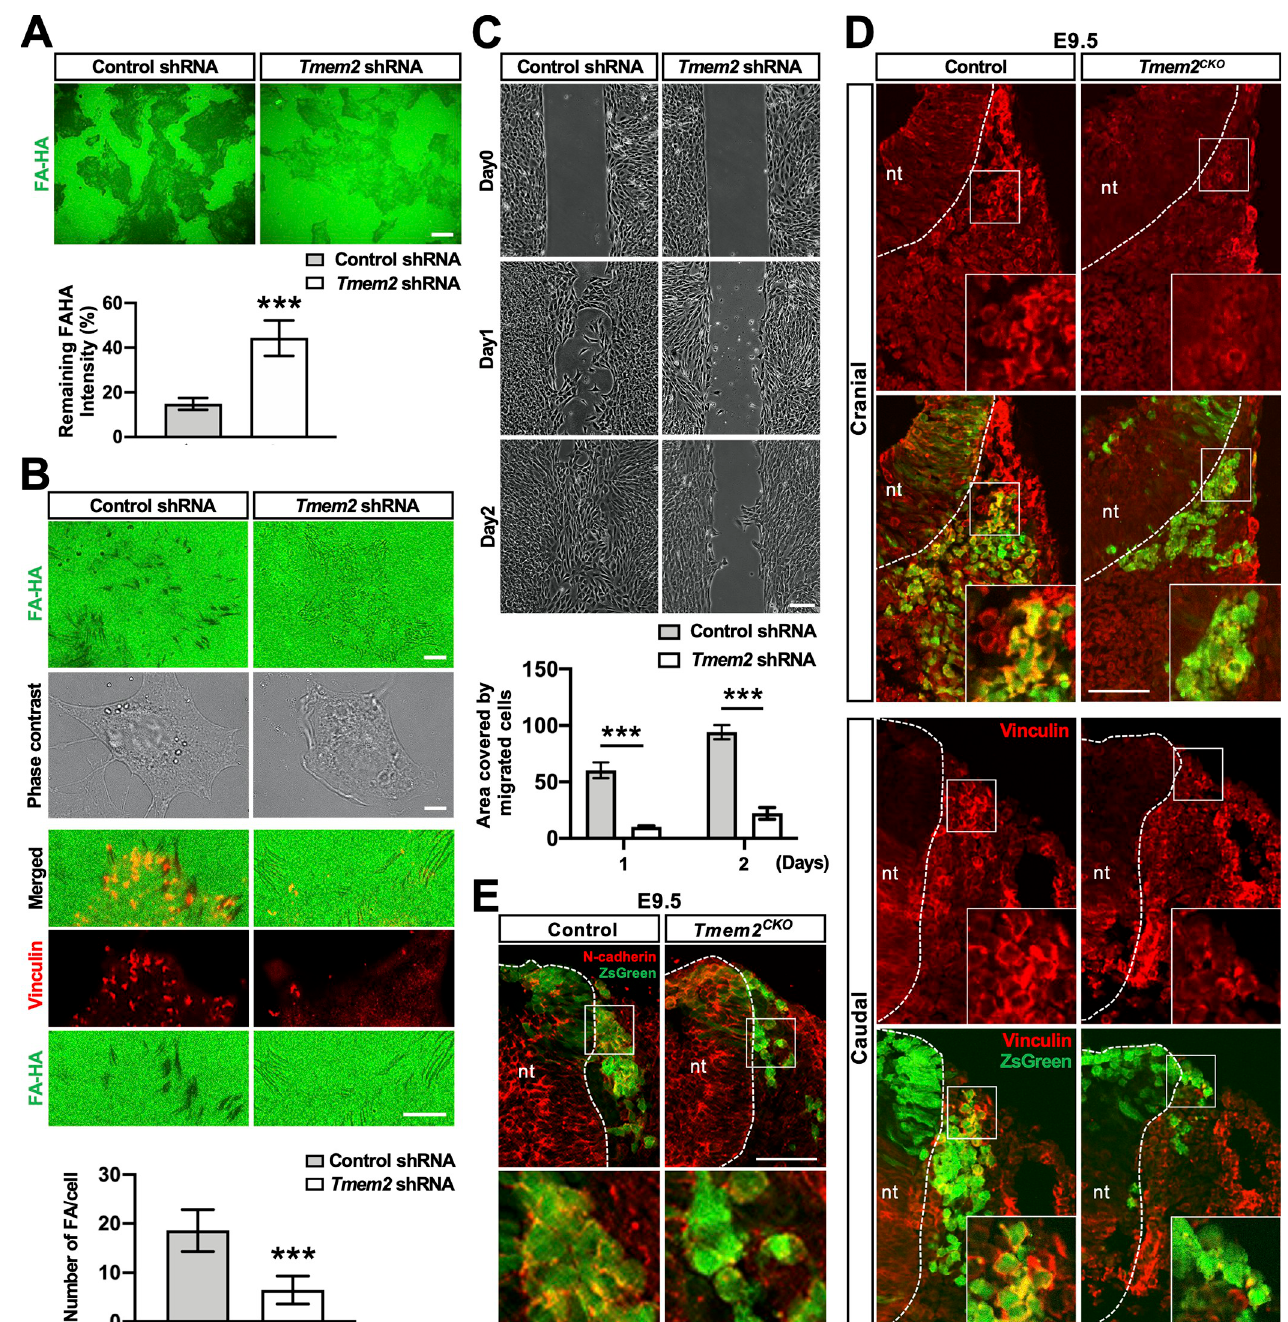
Fig 5. Tmem2 -depleted NCCs are defective in FA formation and migration in HA-rich environments both in vitro and in vivo . ( A ) Cell-based hyaluronidase assay. Tmem2 -depleted and control O9-1 cells were cultured for 48 h on glass coverslips coated with fluoresceinated HA (FA-HA). HA degrading activity is revealed as dark areas in the fluorescent background. The level of HA degradation was also quantitatively compared between Tmem2 - depleted and control O9-1 cells as described in Materials and Methods ( bar graph ). Data represent mean ± SD of the fluorescence intensity underneath a cell relative to that in cell-free area (n > 50 cells per condition pooled from three independent experiments). ��� p < 0.001 by unpaired Student’s t -test. ( B ) O9-1 cells degrade substrate-bound HA at FAs. Cell-based hyaluronidase assays were performed for 16 h and cells were stained for vinculin. In control O9-1 cells, HA degradation occurs coincident with vinculin-positive FAs. In Tmem2 -depleted O9-1 cells, HA degradation and FA formation are greatly diminished. The number of FAs per cell was quantitatively compared between Tmem2 -depleted and control O9-1 cells ( bar graph ). Data represent mean ± SD (n > 30 cells per condition pooled from three independent experiments). ��� p < 0.001 by unpaired Student’s t -test. ( C ) Representative images of the migration of Tmem2 - depleted and control O9-1 cells into a cell-free gap on Col1/HA mixed substrates. Top panels show images of gaps immediately after removal of the ibidi 2-well